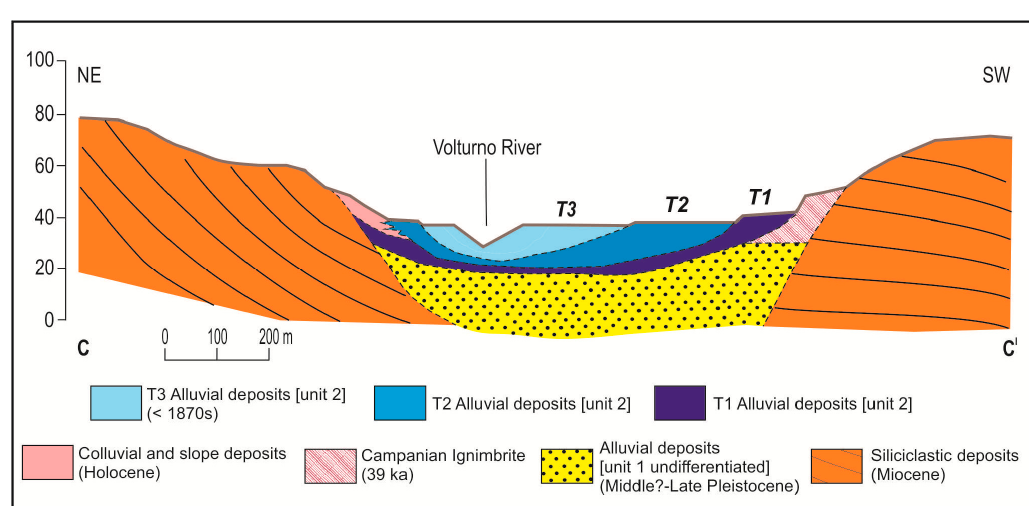
Figure 15. Schematic geological cross section through the Volturno River valley in sector C. For location, see Figure 14.